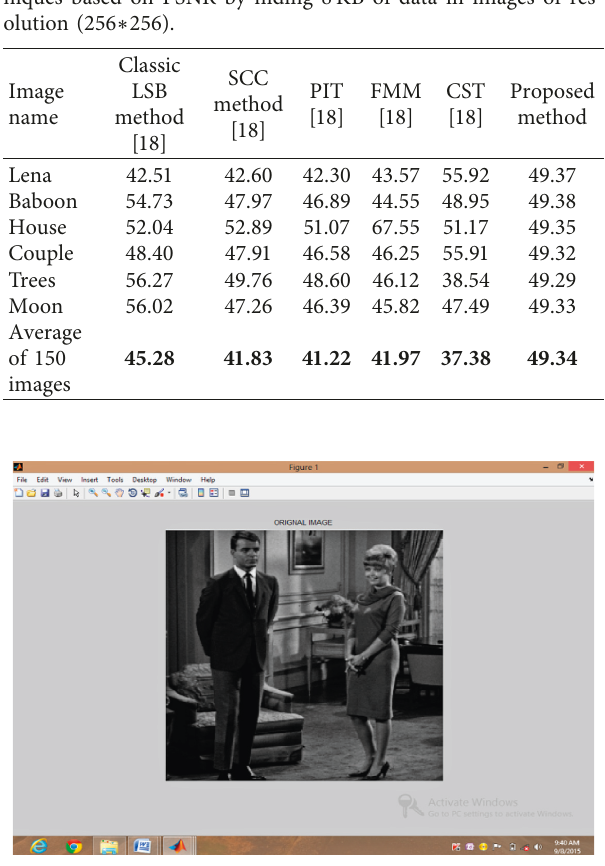
Figure 3: Original image of couple.